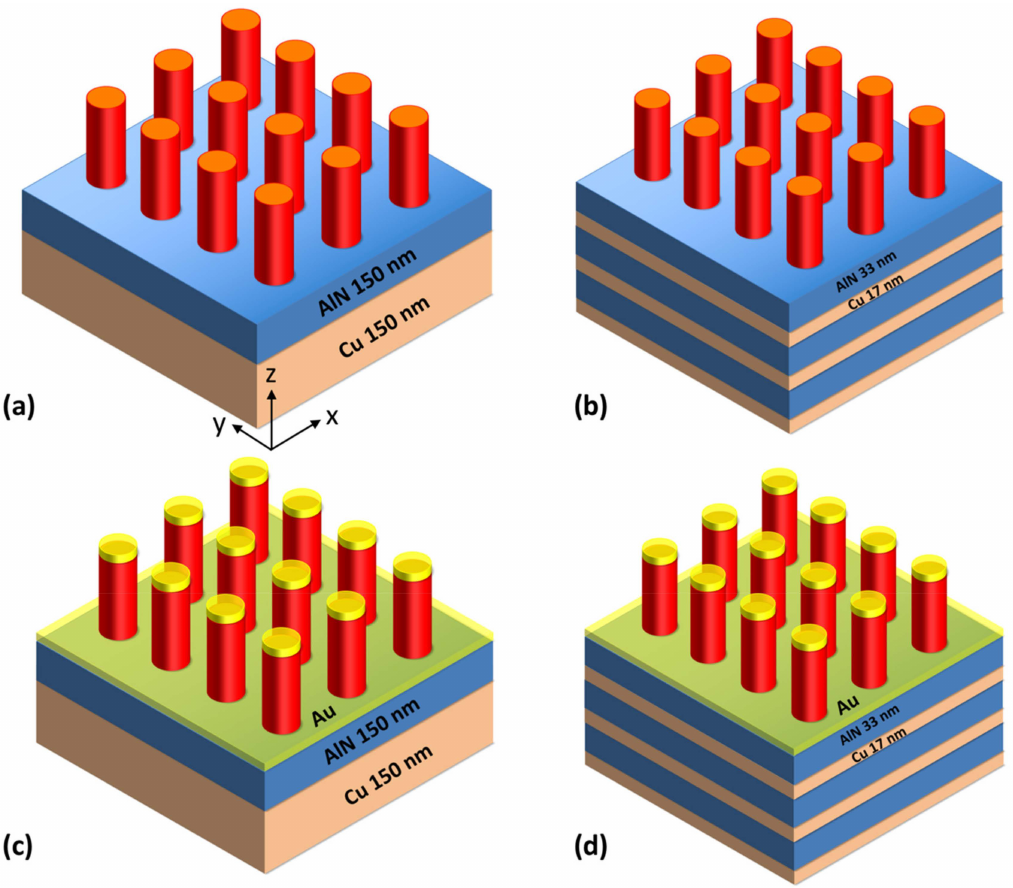
Figure 1. ( a , b ) Sketch of fabricated samples with an array of cylindrical pillars on top of ( a ) bilayer and ( b ) multilayer configurations (three pairs), respectively. ( c , d ) Sketch of the ( c ) bilayer and ( d ) multilayer configurations, respectively, covered by a thin gold layer.